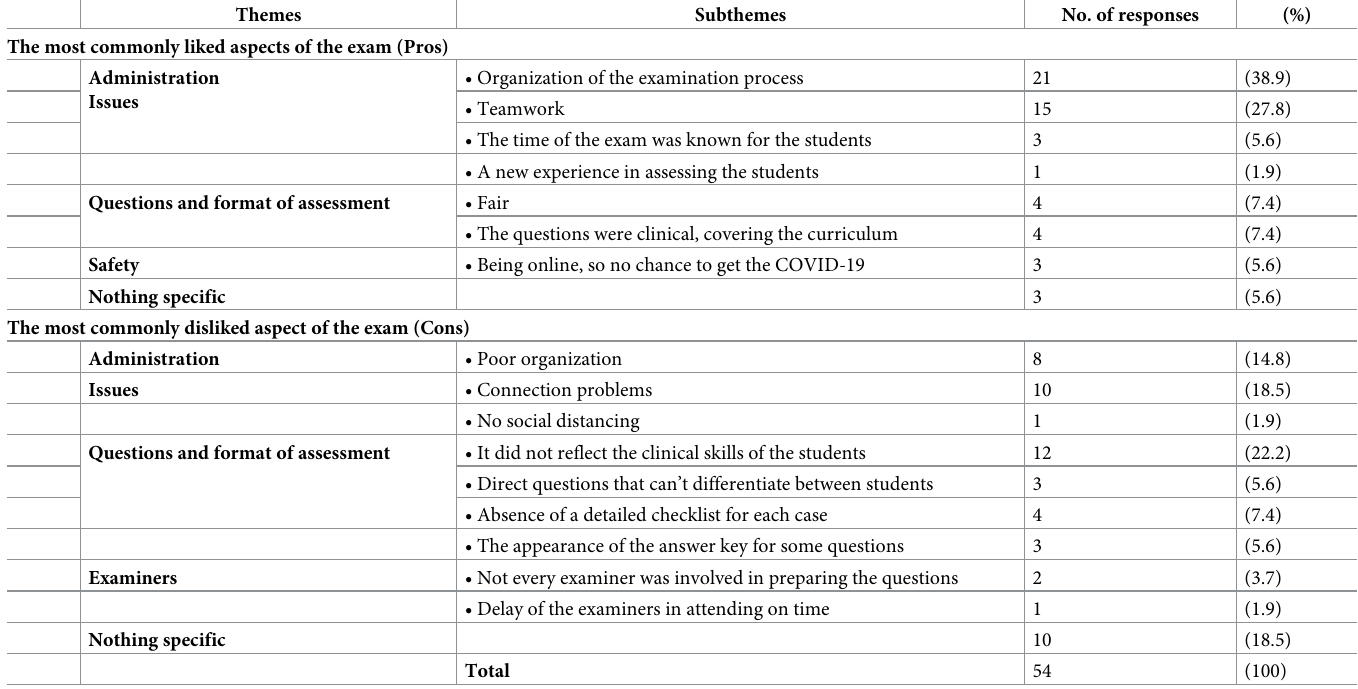
Table 6. Areas that the examiners like (Pros) and dislike (Cons) regarding the assessment